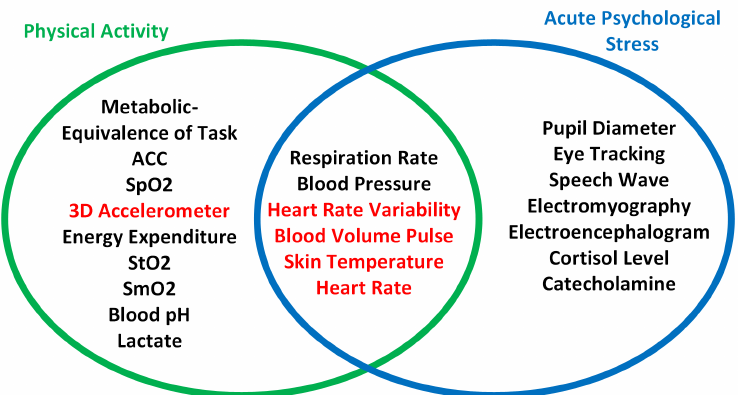
Figure 1. Physological variables measured by Empatica E4 for detecting PA and APS and discrimi- nating between them (in red